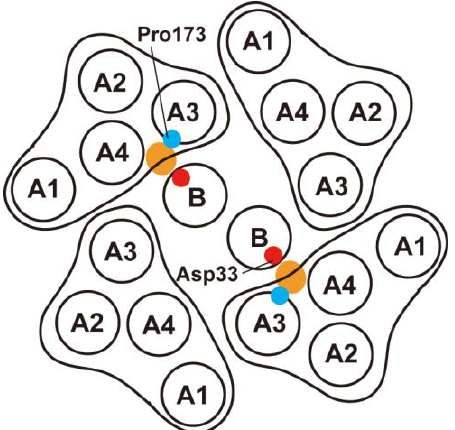
Figure 4. Arrangement of transmembrane segments of the MotA/B complex, which consists of four copies of MotA and two copies of MotB. The view is from the periplasmic side of the membrane. The complex has two proton conducting pathway shown by orange ellipsoids